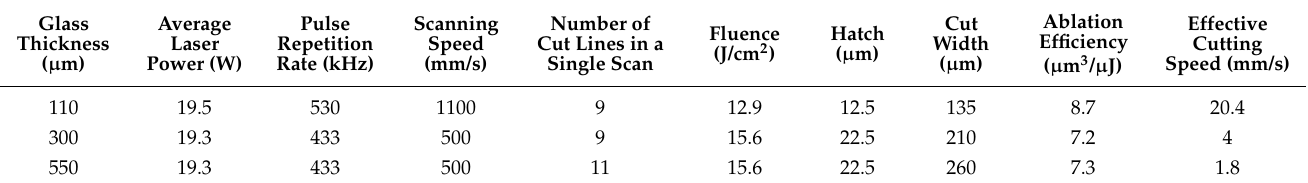
Table 2. Glass-cutting parameters and performance for fs cutting in water. Cutting in water was conducted at a high laser power P max